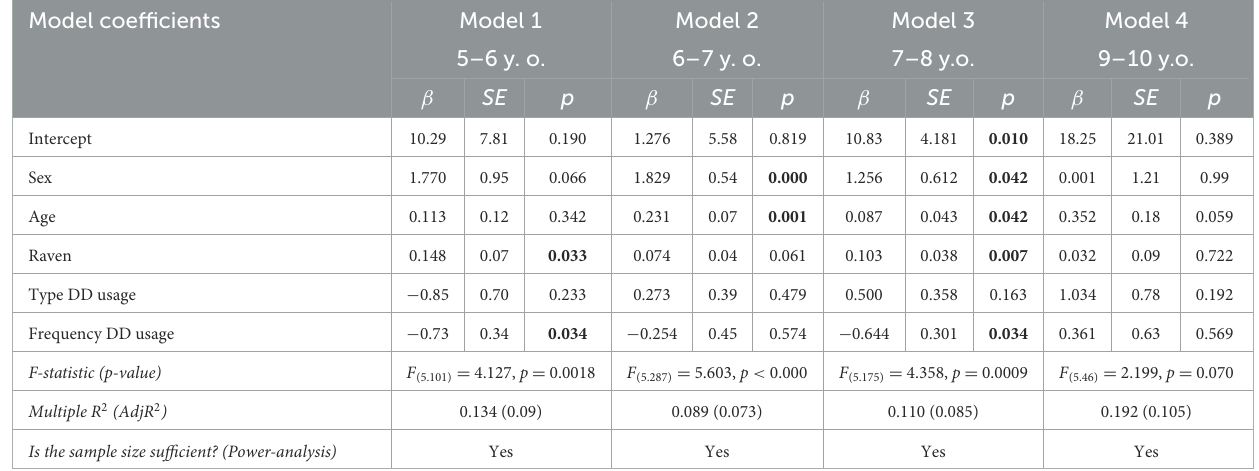
TABLE 4 Multiple linear regression analysis for the study variables predicting verbal working memory from the senior kindergarten group to third school